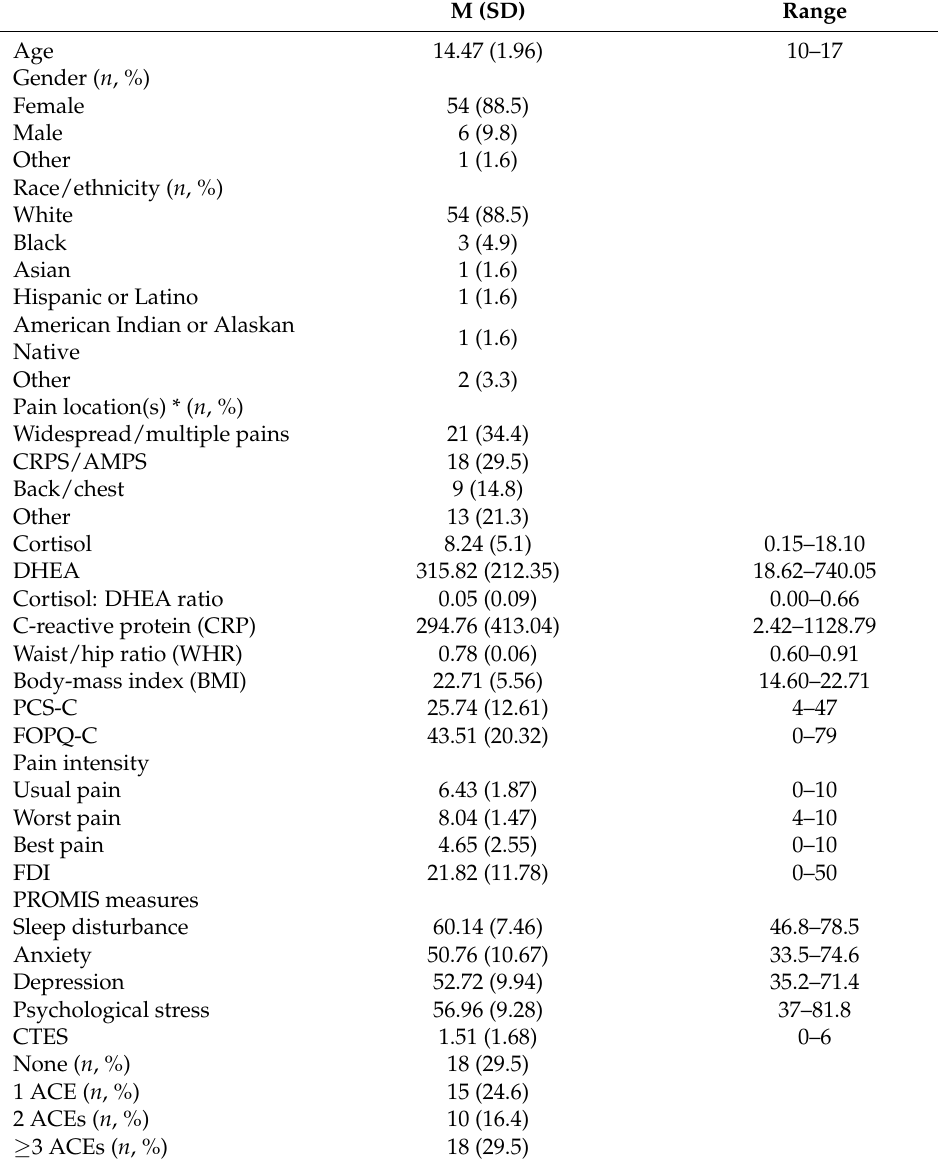
Table 1. Sample Characteristics; N =